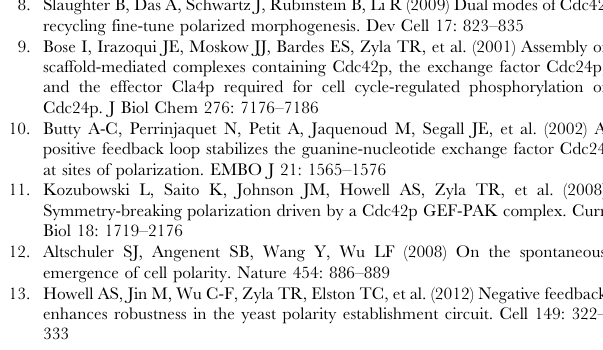
Figure S1 Details of polarization dynamics. A Plot of the growth rate w l,m determined from the linear stability analysis using control cell parameters for different modes l . The first mode corresponds to a growing single cluster whereas the higher modes decay. B Numerically obtained relative Cdc42 protein concentra- tion for different time points of a polarizing cell with a Cdc24 protein number 10 times its control cell value. The initial perturbation was generated as for control cells and is described in the Materials and Methods section. Movie S1 Numerically obtained Cdc42 polarization dynamics. Movie showing time evolution of numerically obtained Cdc42 density on the membrane for control cell values with 2 min time step between frames. Density measured in m m 2 2